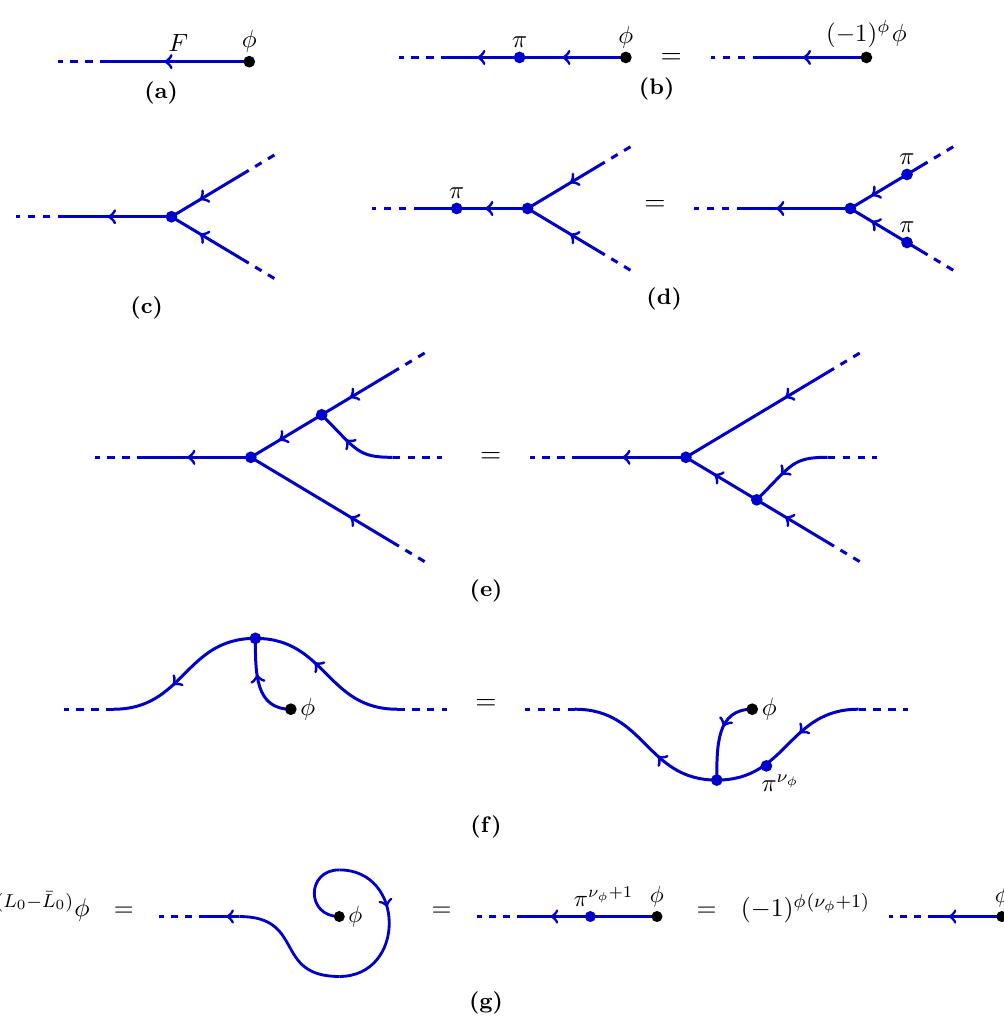
Figure 1 . Properties of the topological line defect F . a) A (cid:12)eld (cid:30) 2 H F sits at the start of F . b) The OPE of the weight zero defect (cid:12)eld (cid:25) and a (cid:12)eld (cid:30) multiplies (cid:30) by (cid:6) 1, depending on its parity. c) The weight zero junction joining two T defects into one. d) Pushing the defect (cid:12)eld (cid:25) through the defect junction. e) Associativity relation for the junction (cid:12)eld. f) Dragging the F defect through a (cid:12)eld (cid:30) of spin grade (cid:23) (cid:30) inserts (cid:25) (cid:23) (cid:30) . g) Rotating (cid:30) 2 H (cid:23) (cid:30)